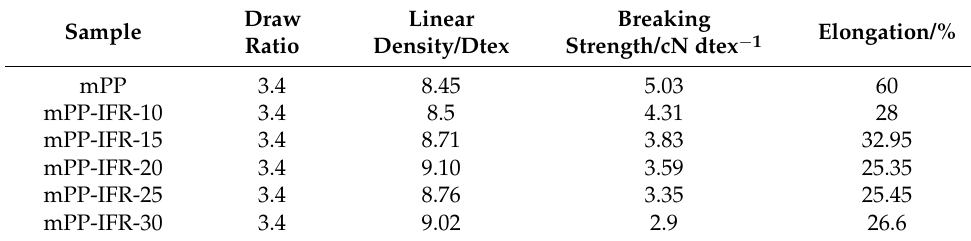
Table 4. Mechanical properties of the polypropylene fibers with different flame retardant content.